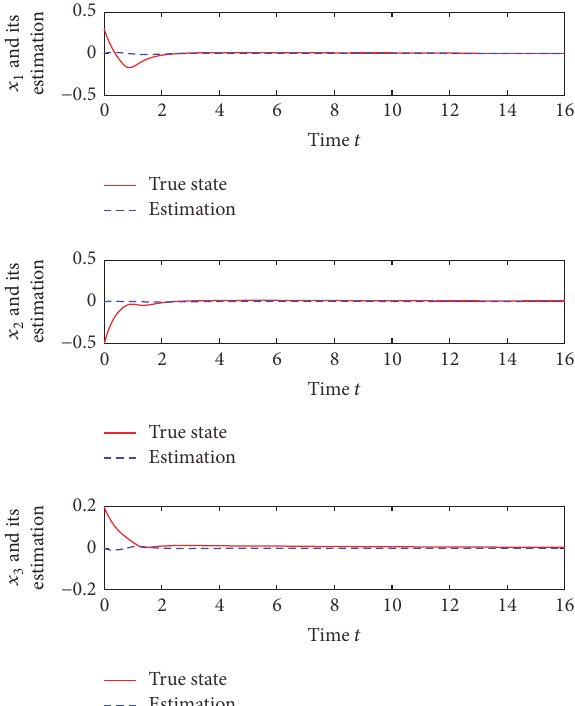
Figure 1: The state variables and their estimation.